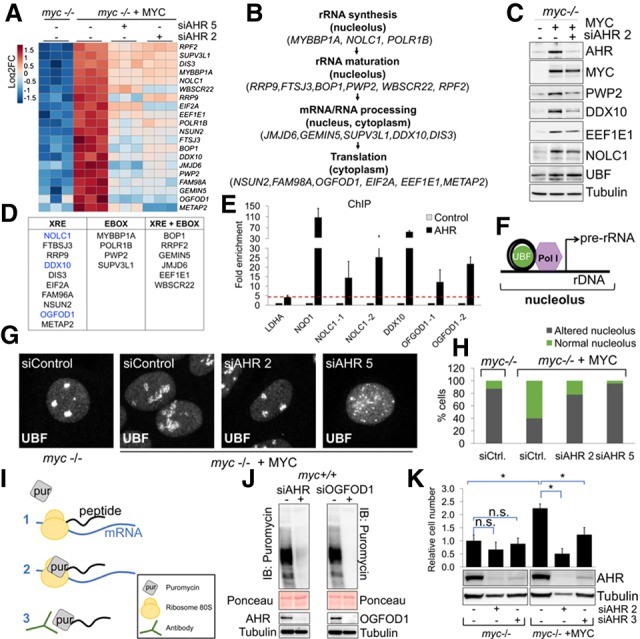
AHR regulates genes involved in protein synthesis. (A) Heat map of genes involved in translation induced by MYC and repressed by siAHR found through RNA-seq. (B) AHR-regulated genes involved in protein synthesis (also see Supplemental Fig. S4B). (C) Western blot of genes shown in A and upstream binding factor (UBF) in myc−/− cells expressing empty vector or MYC 72 h after transfection of siRNA. (D) Table showing the presence of canonical E-box or XRE in the promoters of the genes found in A (also see Supplemental Fig. S5). (E) ChIP of AHR on the promoters of genes shown in A (also see Supplemental Fig. S6A). The red line defines the positive immunoprecipitated signal. (F) UBF and RNA Pol I on the rDNA promoter. (G) Immunofluorescence for UBF 72 h after transfection with control or AHR siRNAs. (H) Quantification of G (also see Supplemental Fig. S6B). (I) Surface sensing of translation (SUnSET) method to measure protein translation rate. (J) Forty-eight hours after transfection with siRNA for AHR or OGFOD1, cells were serum-starved overnight, and FBS and puromycin were added for 1 h prior to harvesting for puromycin Western blotting. (K) Relative proliferation of myc−/− rat fibroblasts expressing vector or MYC transfected with control siRNA or AHR siRNA and counted 6 d after transfection (also see Supplemental Fig. S4C).